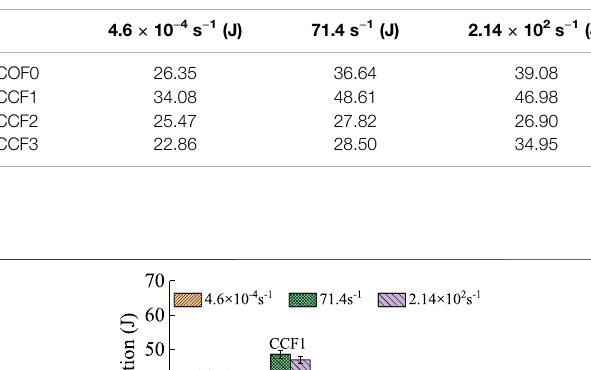
TABLE 2 | The results of total energy absorption under different strain rates for specimens COF0, CCF1, CCF2, CCF3.